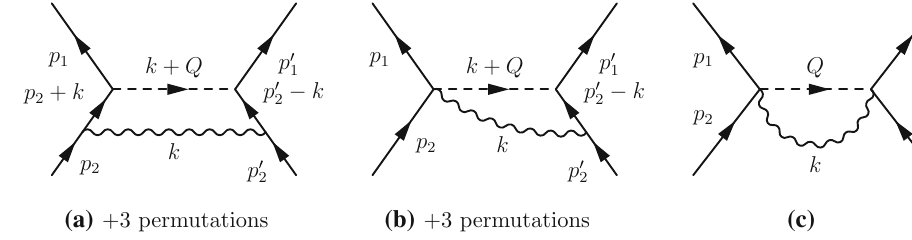
Fig. 7 Crossing S matrix contributions